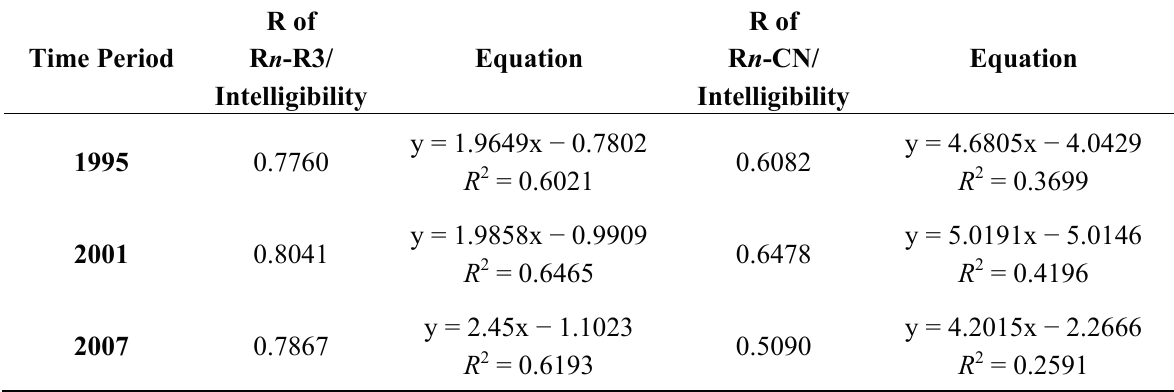
Table 6. Correlation values of global and local measures of ward 18 (where R = correlation, R n = global integration, R3 = local integration, and R 2 = tangent of slope).